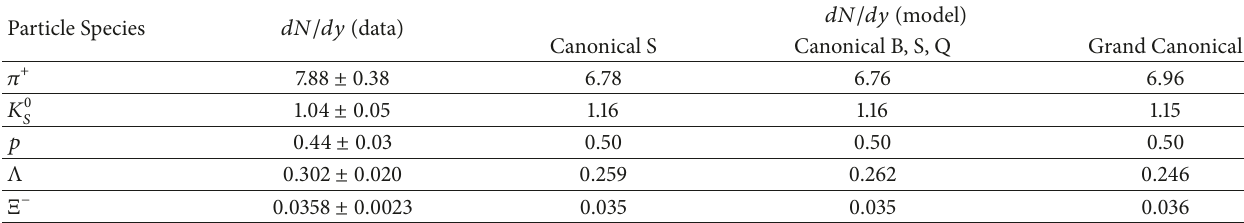
Table 1: Comparison between measured and fitted values for pp collisions at 7 TeV for V0M multiplicity class